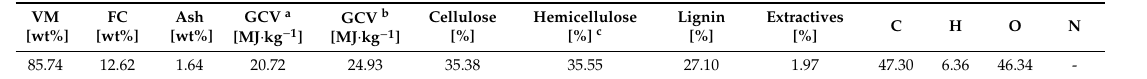
Table 1. Chilean Oak proximate (dry basis), ultimate, and elemental analyses.